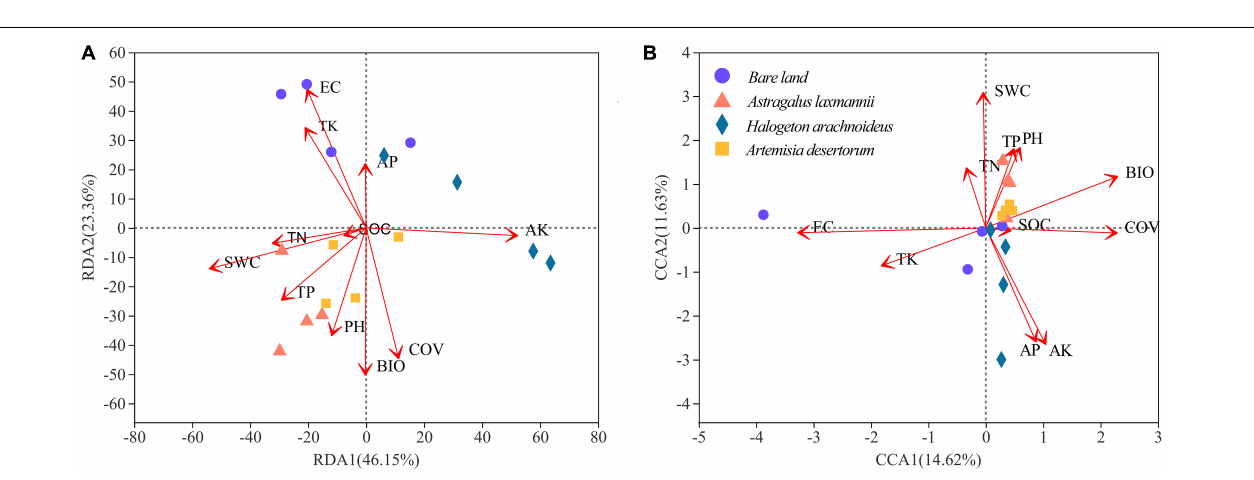
FIGURE 7 | Redundancy analysis (RDA) of (A) bacterial and canonical correspondence analysis (CCA) of (B) fungal communities based on environmental factors. AK/AP, available K/P; BIO, biomass; COV, coverage; EC, electrical conductivity; SOC, soil organic C; SWC, soil water content; TK/TN/TP, total